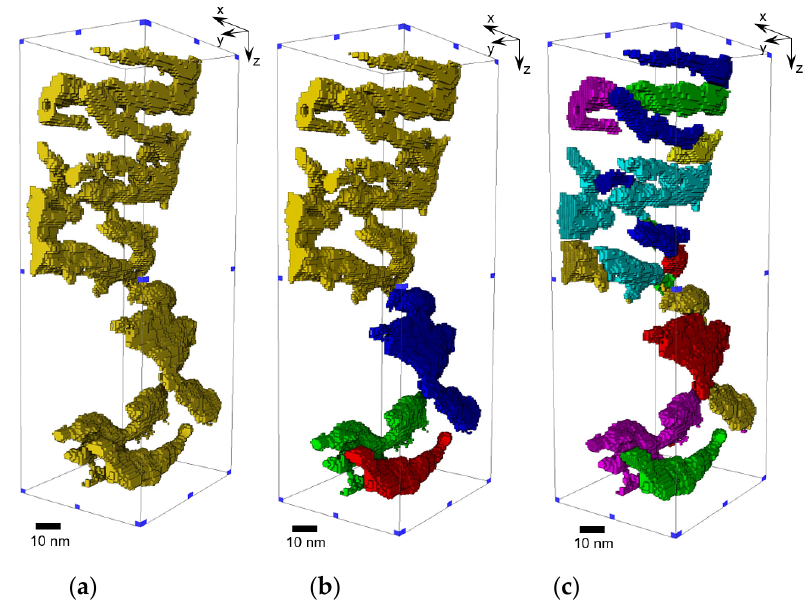
Figure 3. Visualization of the porosity extracted from the STEM reconstruction (pixel size: 1.24 × 1.24 × 1.5 nm). Note: in this representation, we look upon the outlet face used for simulations. ( a ) Extracted pore volume connected across the x-dimension (6.5% porosity); ( b ) The 4 existing flow pathways. ( c ) Individual pores.